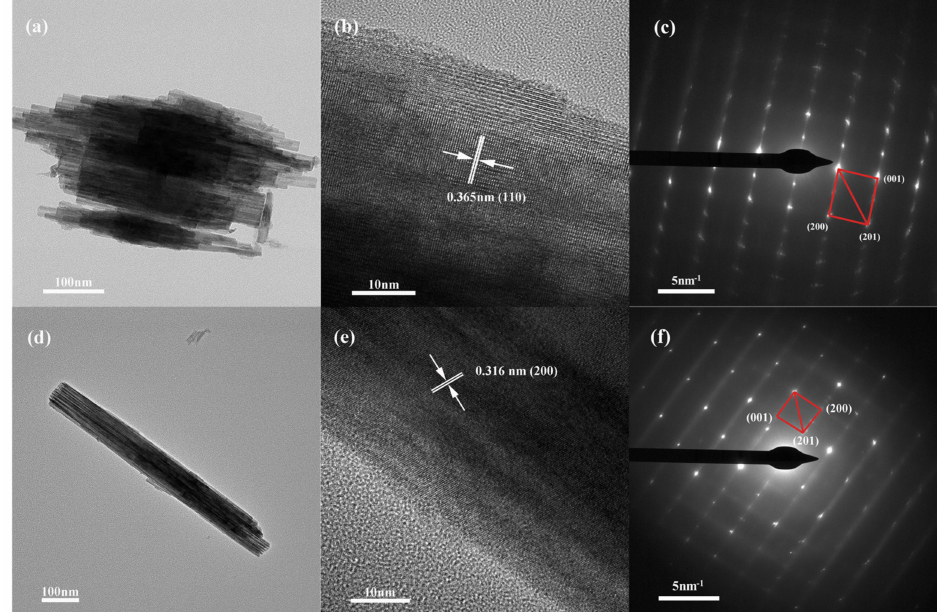
Figure 4. TEM, HR-TEM, and SAED images of the products created with different initial reactants. ( a – c ) 1.4432 g Na 2 WO 4 2H 2 O, 30 mL 0.25 mol L − 1 H 2 SO 4 , ( d – f ) 1.4432 g Na 2 WO 4 2H 2 O, 20 mL 0.375 mol L − 1 H 2 SO 4 , and 10 mL